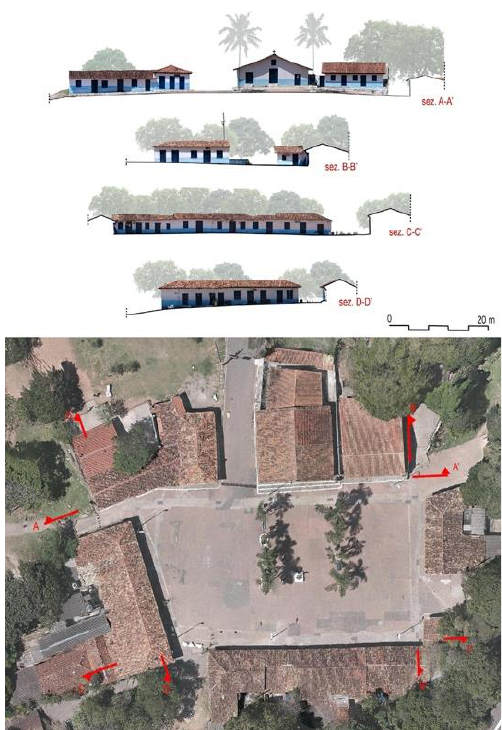
Figure 8. Final Drawings obtained from Unmanned Aerial Photogrammetric Survey: it was possible to add the photographic information to the CAD